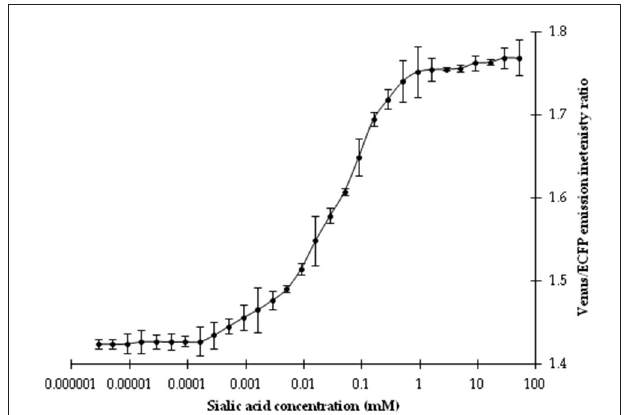
FIGURE 2 | Spectral analysis of FLIP-SA. Change in fluorescence emission was observed from 440 to 620nm using fluorescence spectrophotometer without NeuAc (control) and with NeuAc (1 and 10mM). 0.20 mg/ml sensor protein was taken.